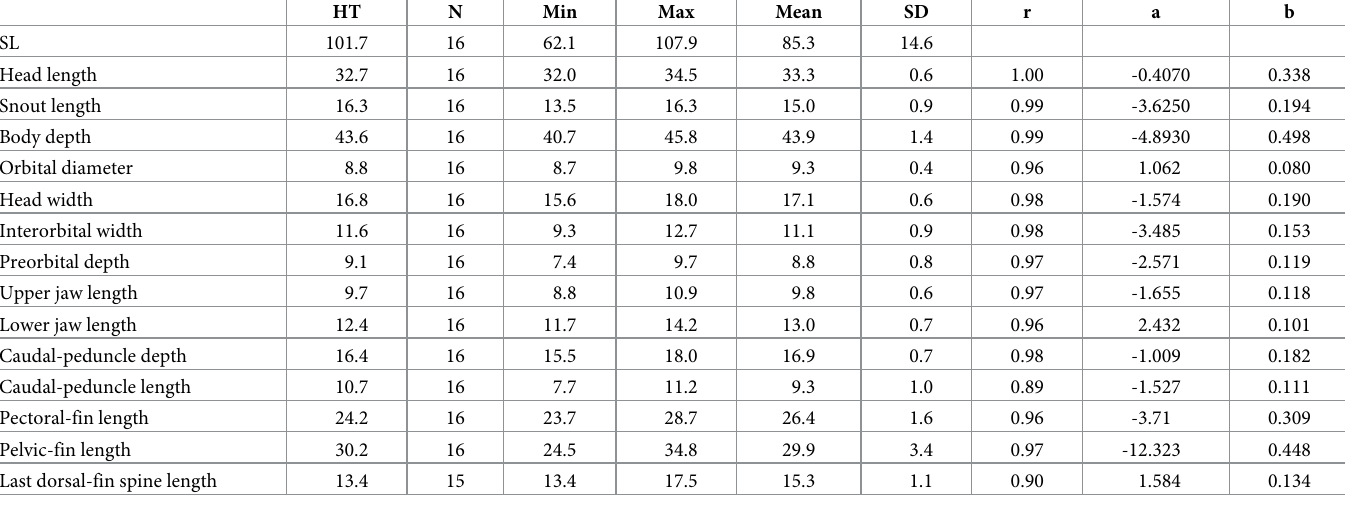
Table 17. Australoheros mboapari . Size (SL), proportional measurements (per cent of SL) and linear regression parameters. HT